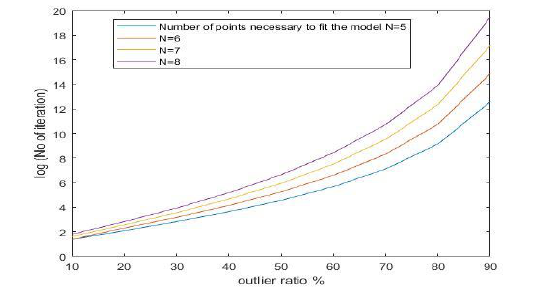
Figure 3 . Number of RANSAC iterations as a function of outlier ratio and model